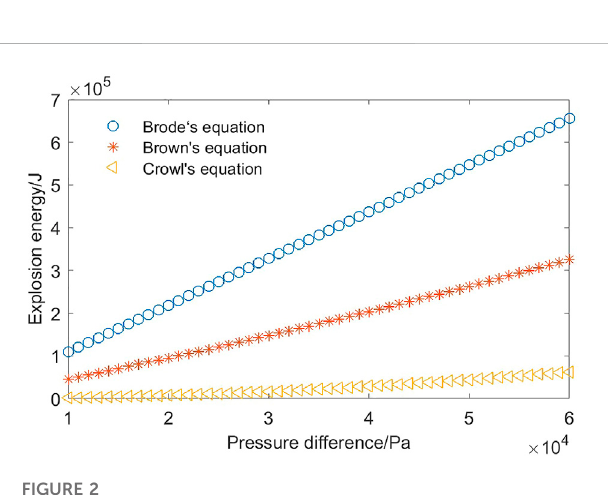
FIGURE 2 Explosion energy at various pressure